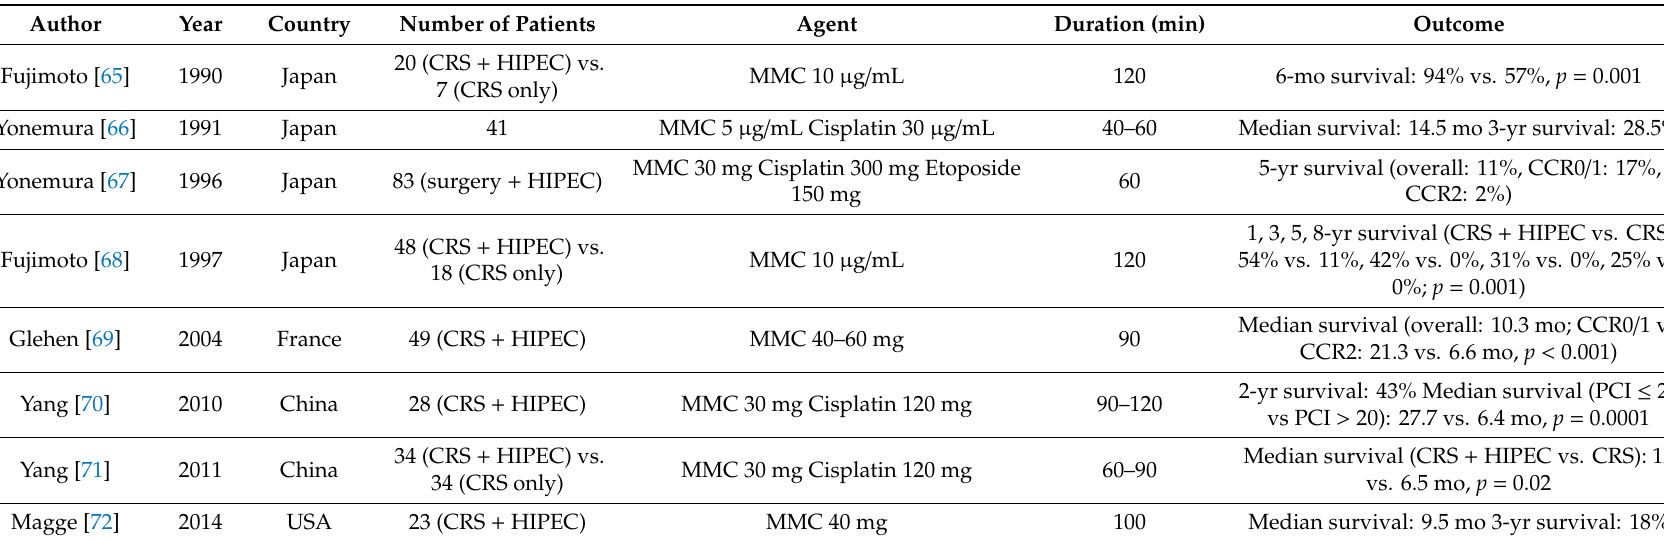
Table 2. Prospective or Randomized controlled studies evaluating the e ff ect of HIPEC in established peritoneal